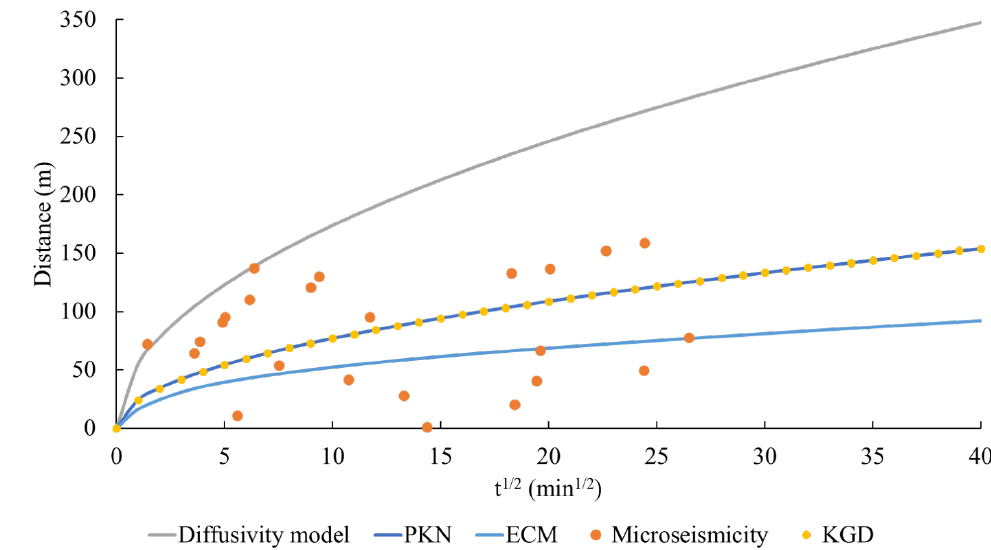
Figure 9. Comparison of fracture length increment along maximum in-situ stress direction using diffusivity, PKN, KGD, and ECM models. The orange dots indicate recorded microseismicity along the maximum in-situ stress direction.